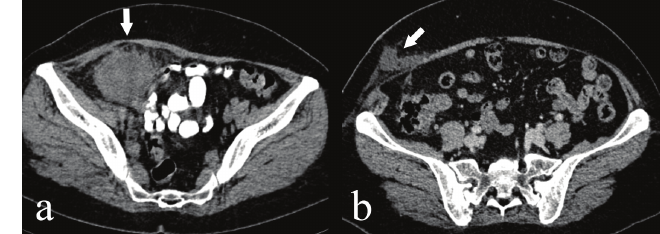
Figure 1 - Abscess formation (arrow) on pre-interventional CT (a), the drainage catheter on X-ray during scopic control (b) and the progression in abscess volume (arrow) on post- interventional CT (c) 17 days after percutaneous drainage in 18-year-old man with perforated appendicitis.